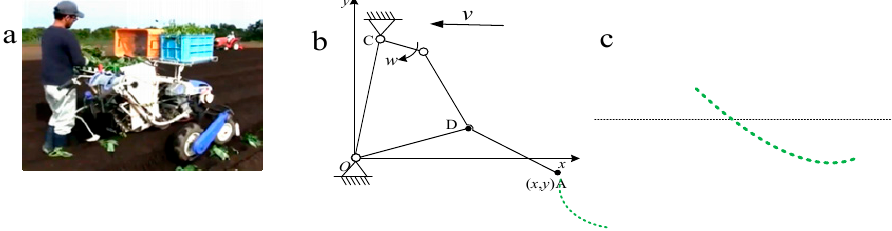
Figure 12. Connecting rod-type sweet potato transplantation. ( a ) Transplanter; ( b ) transplanting principle; ( c ) transplanting trajectory.